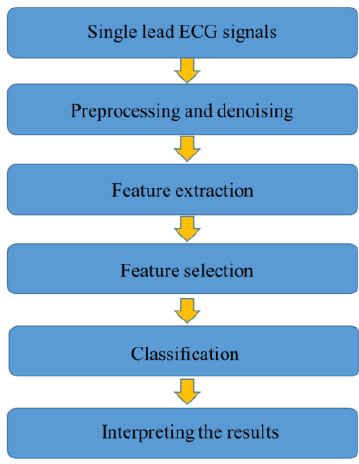
Fig. 1. The overall steps of the OSA detection with the help of ECG signals.